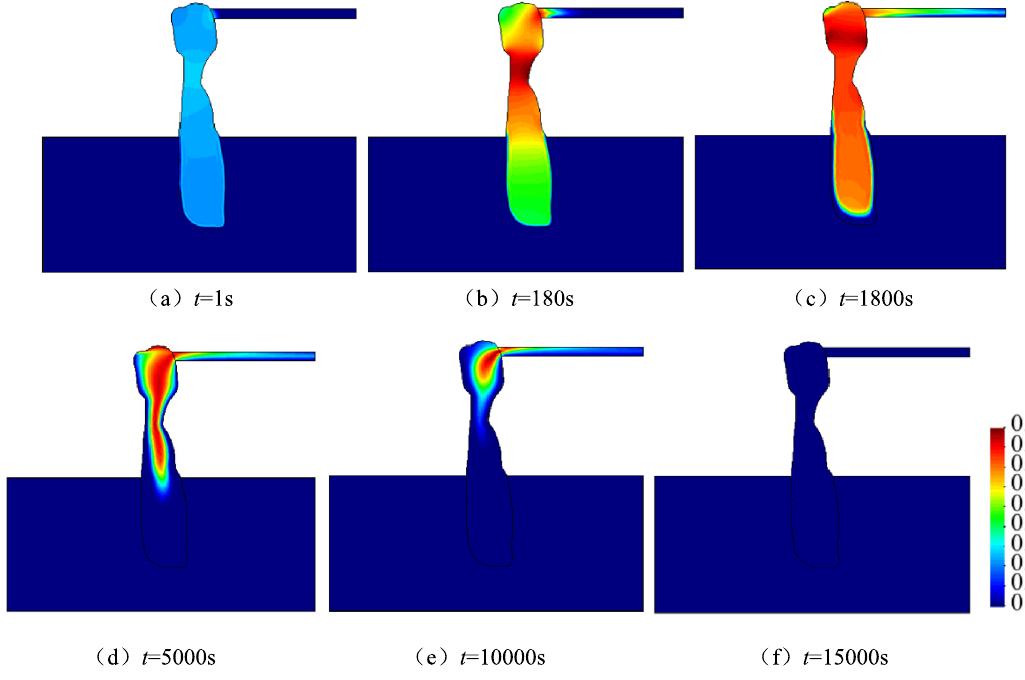
Figure 13. Space–time evolution process of concentration.